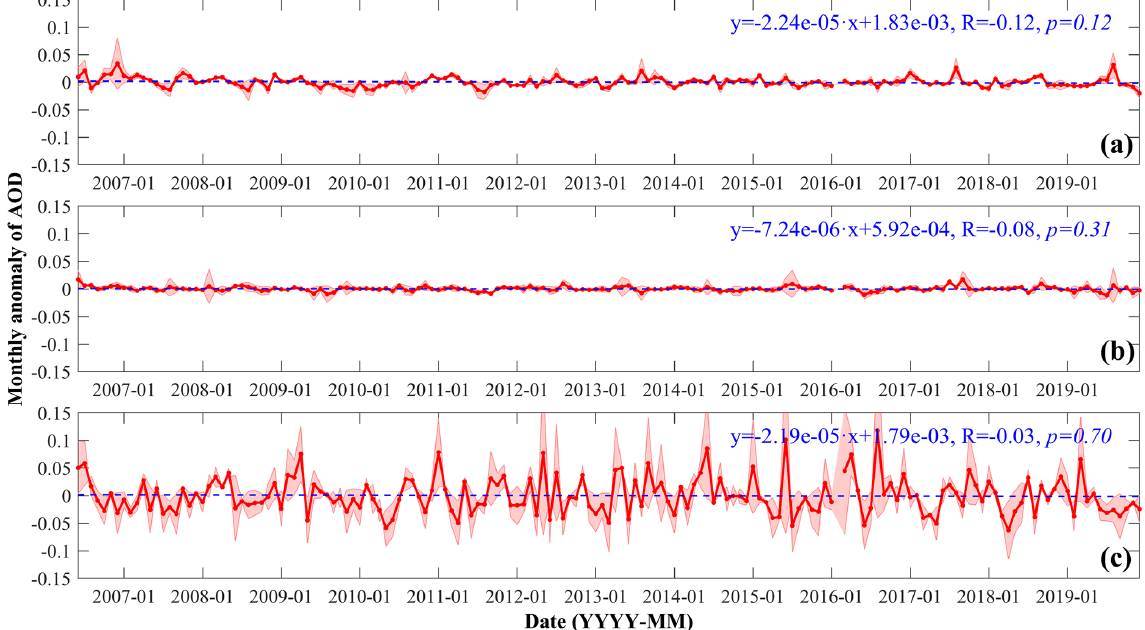
Figure 4. Temporal variation in monthly AOD anomalies from June 2006 to December 2019 over the (a) Arctic, (b) Antarctic and (c) TP. The solid red lines and shadows represent the deseasonalized monthly AOD anomalies and SDs, respectively, while the dotted blue lines represent the linear